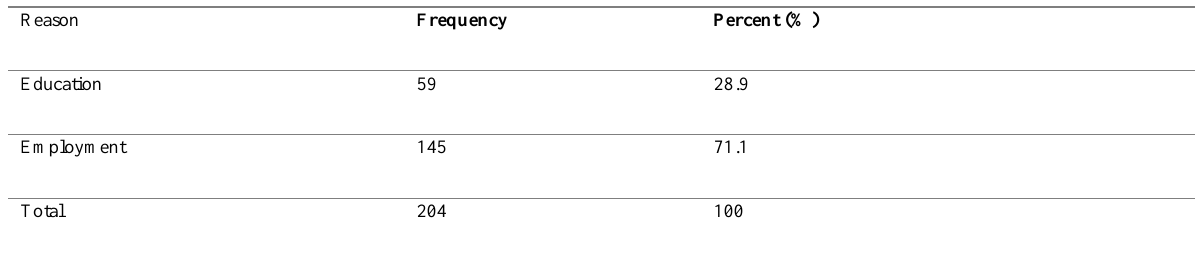
Table 6. Motivational Factors for Rural-Urban